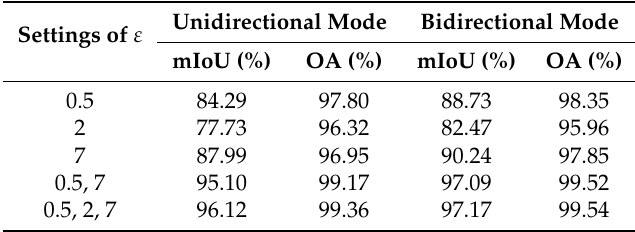
Table 7. Comparison of different settings of region size threshold ε